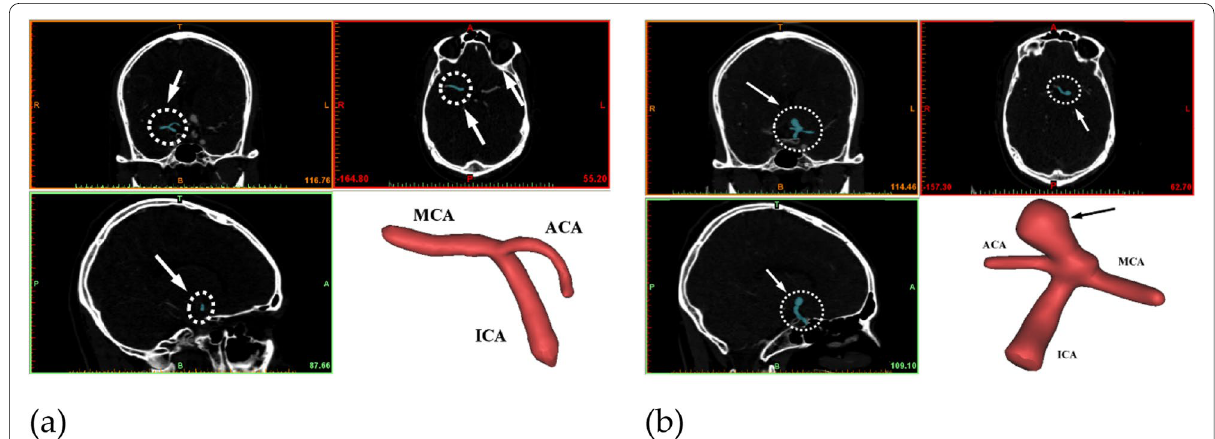
Fig. 2 Different views of CT scan of ICA bifurcation. a : Normal; b : Giant